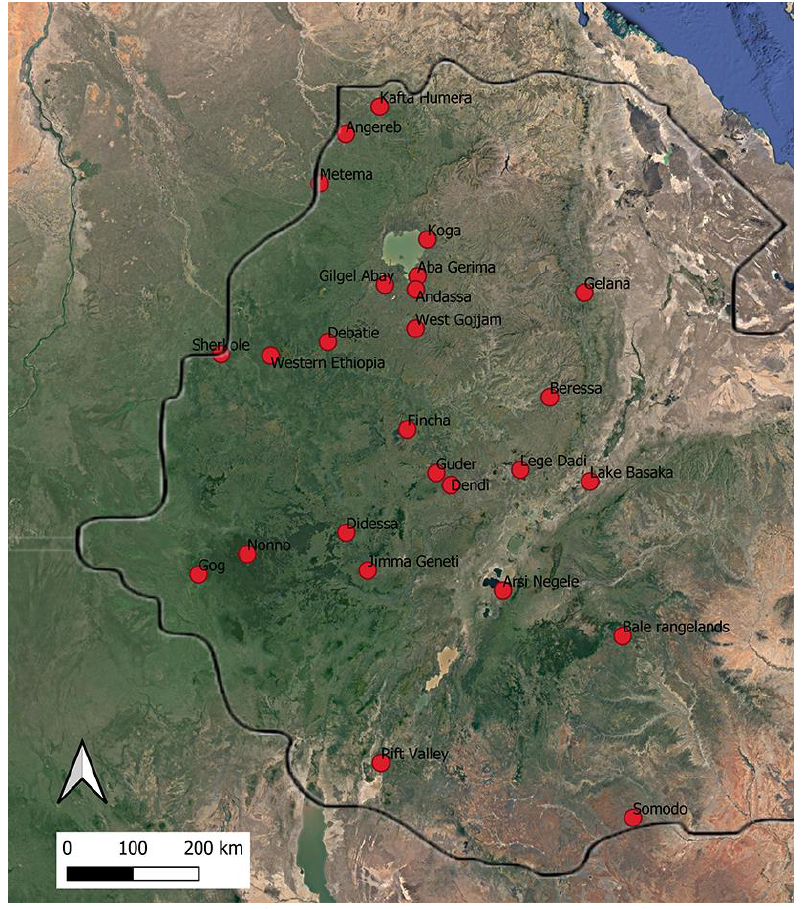
Table 2. Characteristics of the study area for the selected case studies in Ethiopia.